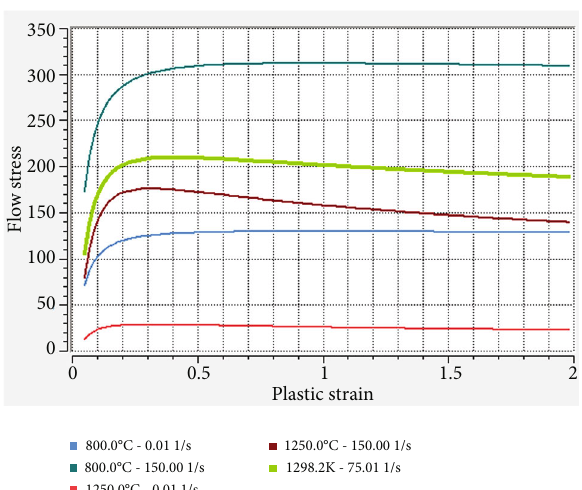
Figure 3: Hardening curve of AISI 1015